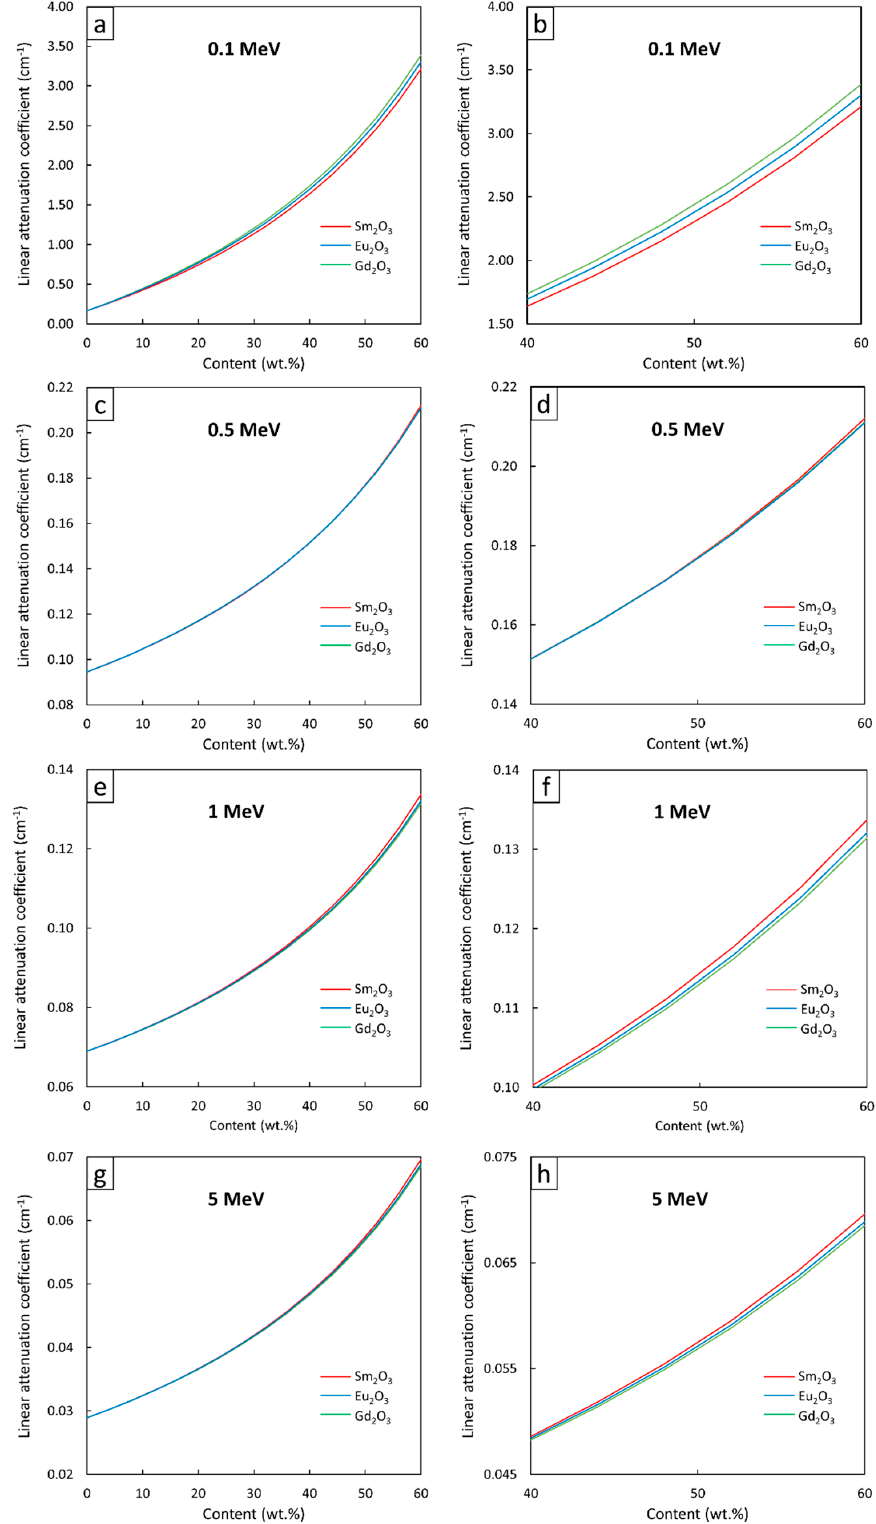
Figure 5. μ values of Sm 2 O 3 /HDPE, Eu 2 O 3 /HDPE, and Gd 2 O 3 /HDPE composites using XCOM, with filler contents varied from ( a , c , e , g ) 0–60 wt.%, and ( b , d , f , h ) 40–60 wt.%, determined at photon energies of ( a , b ) 0.1 MeV, ( c , d ) 0.5 MeV, ( e , f ) 1 MeV, and ( g , h ) 5 MeV.